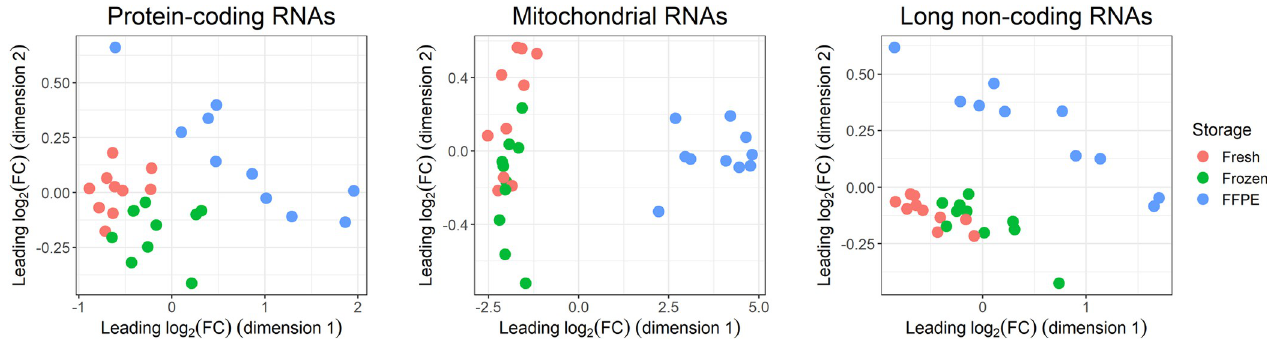
Fig 3. Multidimensional scaling plots of gene expression profiles of the protein-coding, mitochondrial, and long non-coding RNA subsets. Colours correspond to storage condition (red = fresh tissue, green = frozen tissue, blue = FFPE tissue). Abbreviations: FC = Fold-change, FFPE = Formalin-fixed,